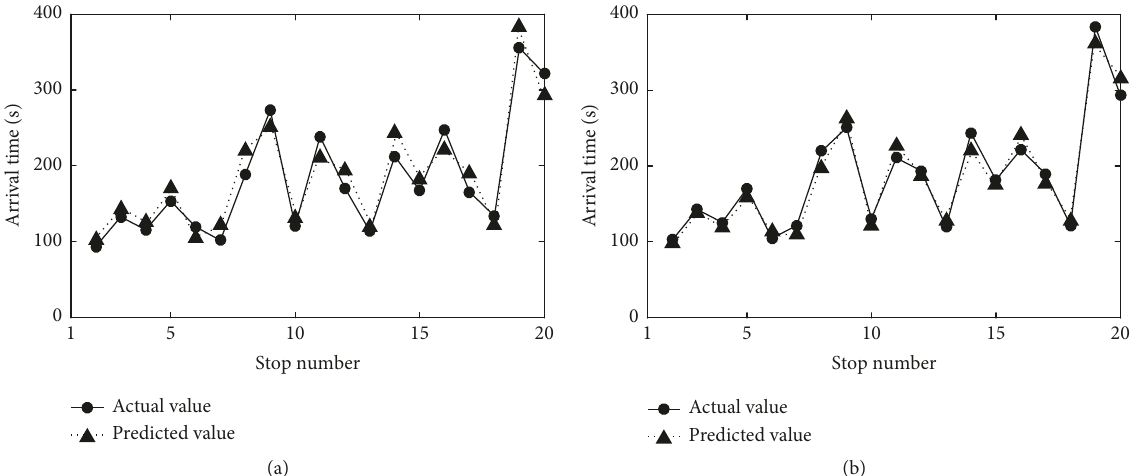
Figure 5: Comparison of predicted bus arrival times of WNN and IPSO-WNN models with actual values: (a) WNN model; (b) IPSO-WNN model.